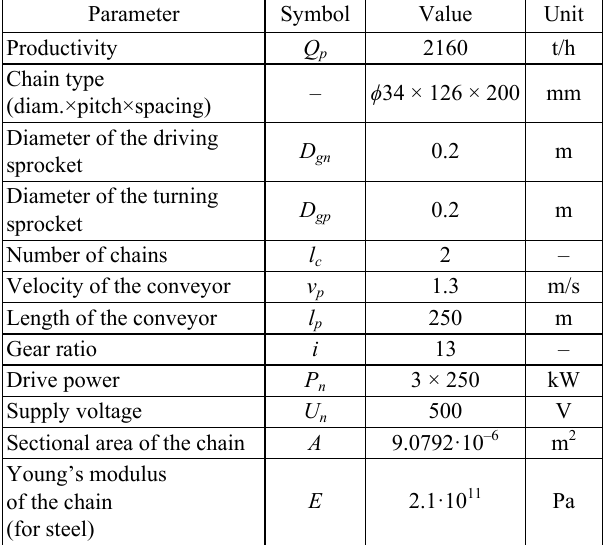
Table 1. Parameters of the conveyor JOY ® BLS